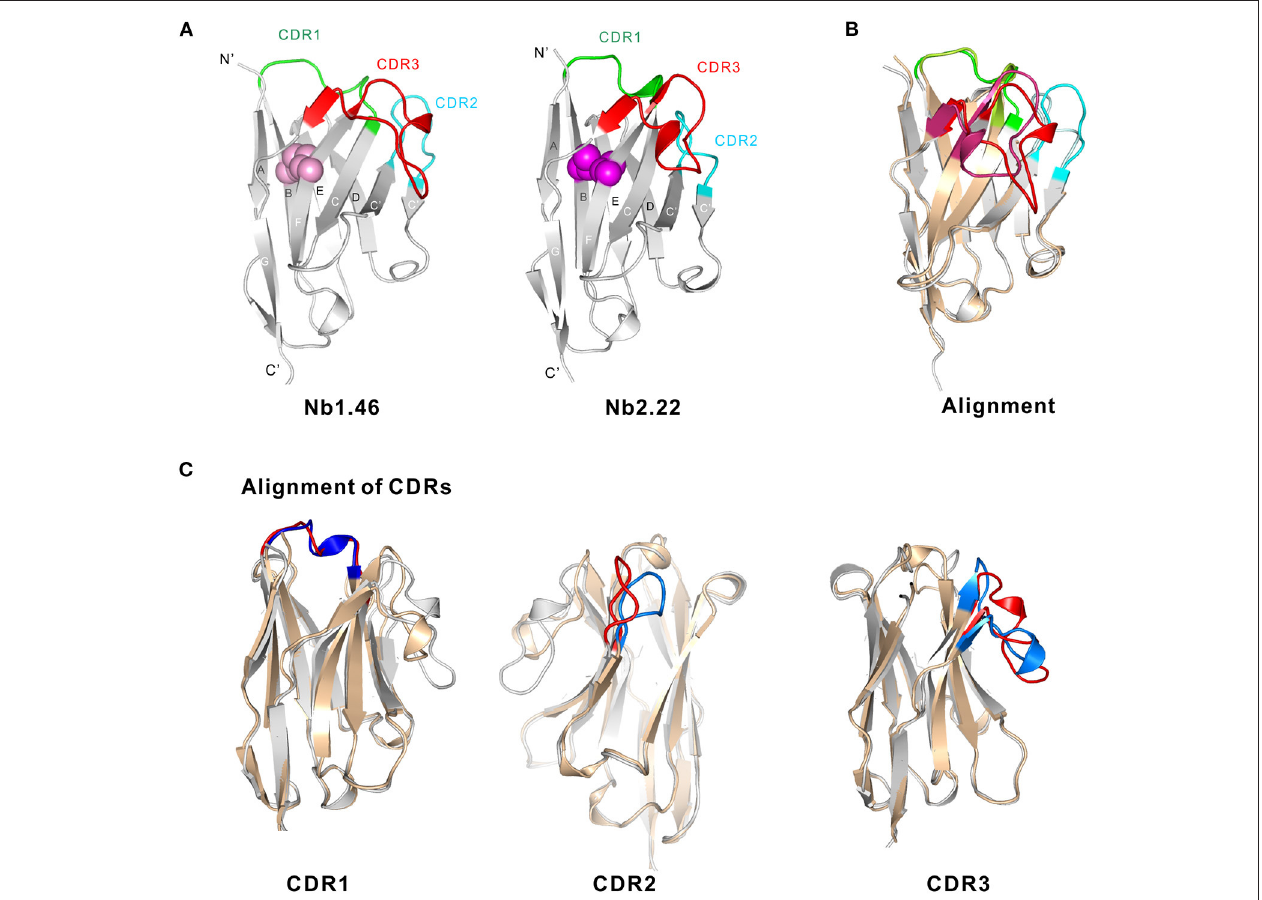
FIGURE 6 | Structural basis of Nb1.46 and Nb2.22. (A) The cartoon view of the Nb1.46 and Nb2.22, the CDR1, CDR2, CDR3 are shown in the color green, cyan and red, respectively, the cysteine involved in disulfide bond formation are denoted as pink sphere for Nb1.46 and violet sphere for Nb2.22. (B) The alignment of Nb1.46 to Nb2.22, whereby Nb1.46 is colored in gray and Nb2.22 is colored in wheat. (C) The details of CDRs alignment of Nb1.46 to Nb2.22, whereby Nb1.46 is colored in gray and its CDR in red, whereas Nb2.22 is colored in wheat and its CDR in